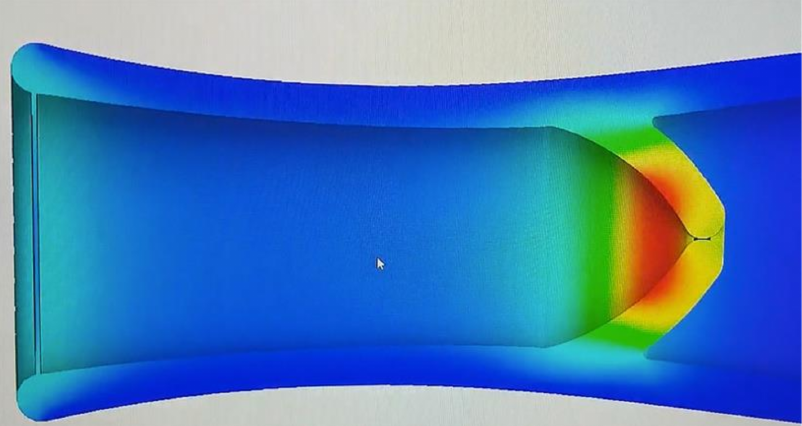
Figure 7. Version 1.0 of the lymphatic vessel: deformation test with open valve